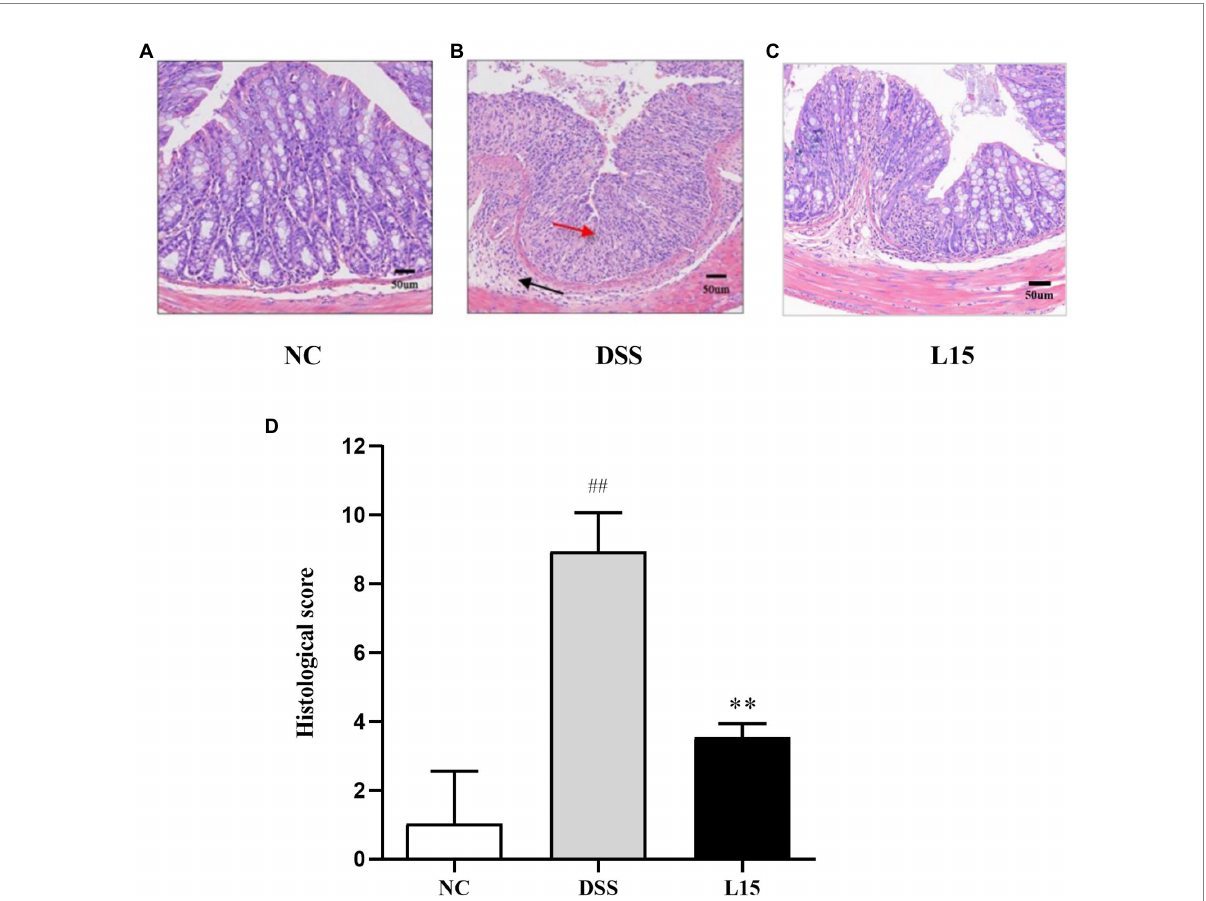
FIGURE 3 Effect of L. plantarum L15 supplementation on the mouse colon histological changes (H&E). (A) NC group (×40), (B) DSS group (×200), (C) L15 group (×200), (D) Associated histological scores. NC, normal control group; DSS, dextran sulfate sodium-induced colitis group; L15, Supplement L. plantarum L15 group. Data are presented as mean ± SD. ##p < 0.01 and #p < 0.05 vs. the NC group. ** p < 0.01 and * p < 0.05 vs. the DSS